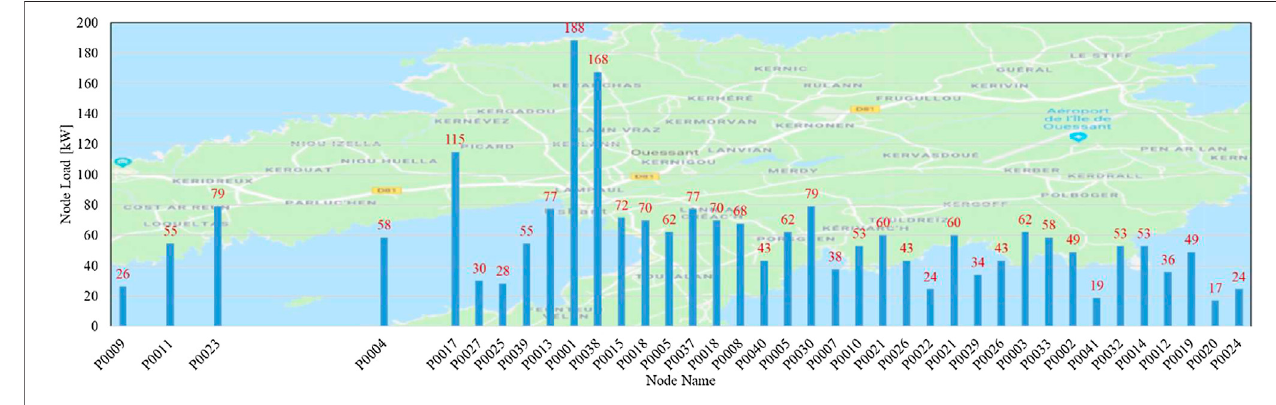
FIGURE 9 | Power load at each node for the peak load demand (March 2013).